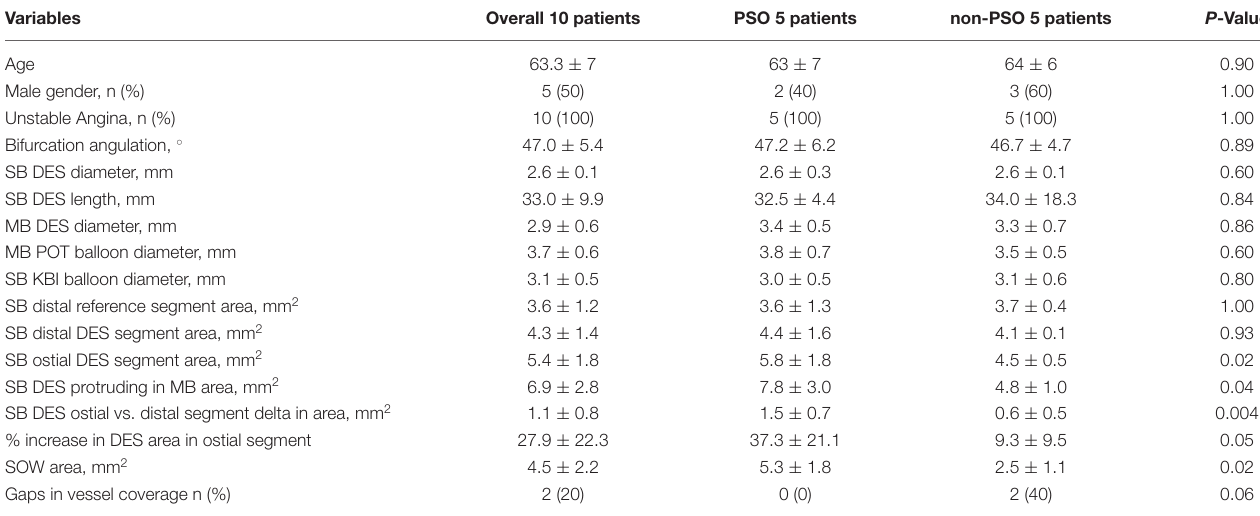
TABLE 1 | Procedural characteristics and Optical Coherence Tomography (OCT) Findings. Variables Overall 10 patients PSO 5